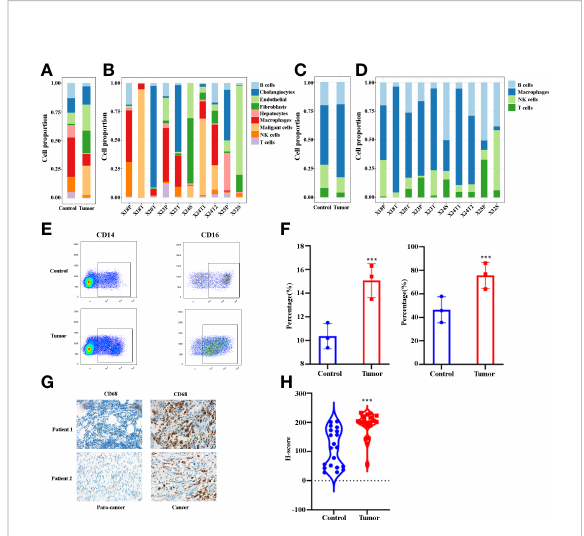
FIGURE 2 (A) Bar plots showing the proportion of cell types in tumor and control samples. (B) Bar plots showing the proportion of cell types in each sample. (C) Bar plots showing the proportion of immune cell types in tumor and control samples. (D) Bar plots showing the proportion of immune cell types in each sample. (E) The representative fl owcytometry images of CD14 and CD16 expression in CD45 + cells in control and tumor samples. (F) Quantitative analysis revealed CD14 and CD16 expression in tumor and control tissues (n = 3). (G) The representative IHC images of CD68 expression in control and tumor samples. (H) Quantitative analysis show CD68 expression in tumor and control tissues (n = 20). ***P < 0.001.